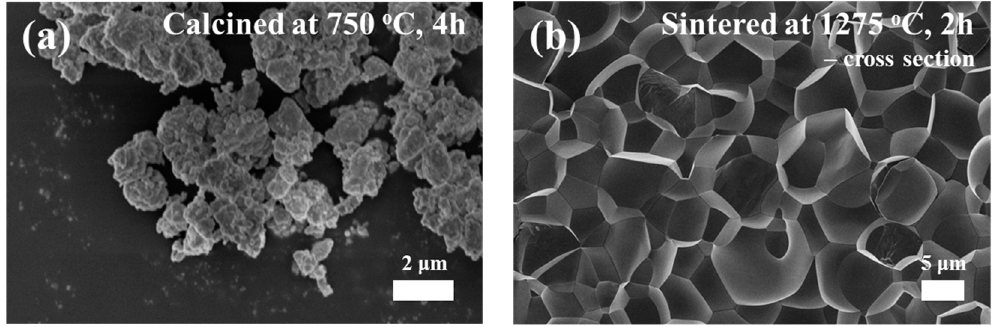
Figure 3. SEM images of the 0.675PbMgNbO 3 -0.325PbTiO 3 powders after calcination ( a ) and after the sintering ( b ).